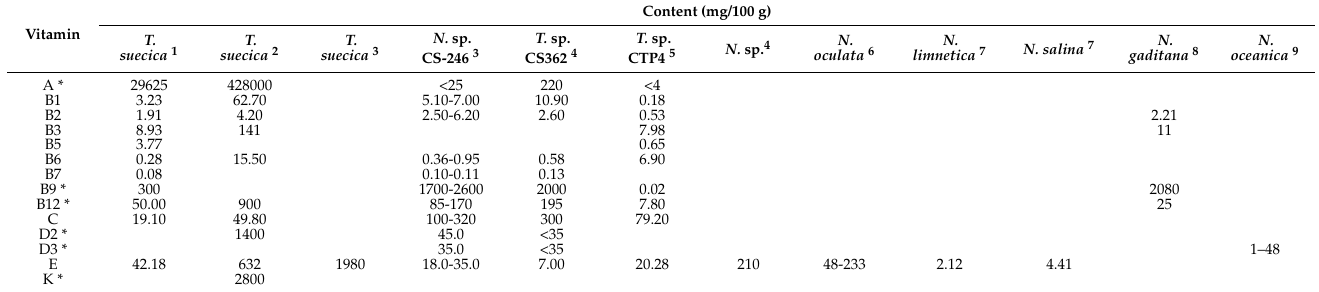
Table 4. Vitamin content in Nannochloropsis sp. and Tetraselmis sp. microalgae